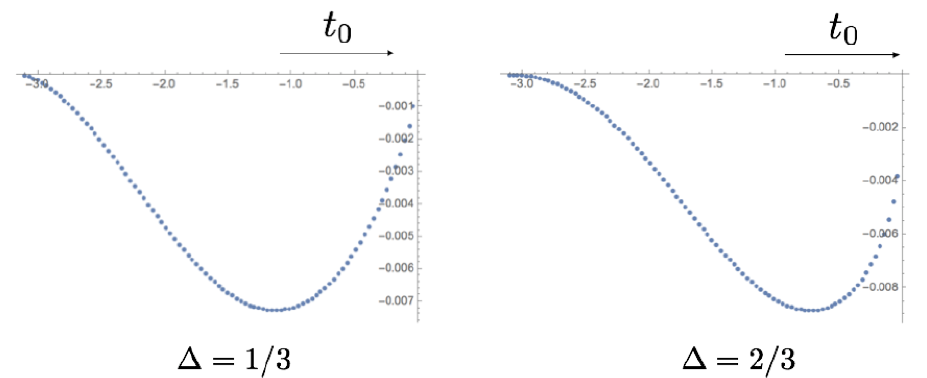
Figure 4 . Plots of Averaged null energies on null geodesics when the theory is deformed by boundary double trace deformation. The null geodesic starts at boundary of AdS with (cid:18) = (cid:25) and t = t 0 , then ends at AdS boundary with (cid:18) = 0 and t = t o + (cid:25) . Averaged null energy is divergent and we regularized it using a de(cid:12)ned in appendix A. The averaged null energy is proportional to g and the plot is describing the coe(cid:14)cient of g . Note that on any null geodesic incoming from a 2(cid:1) a 2(cid:1) (cid:18) = (cid:25) and (cid:0) (cid:25) < (cid:18) < 0, null energy is negative, when g is positive. This behavior is (cid:1)